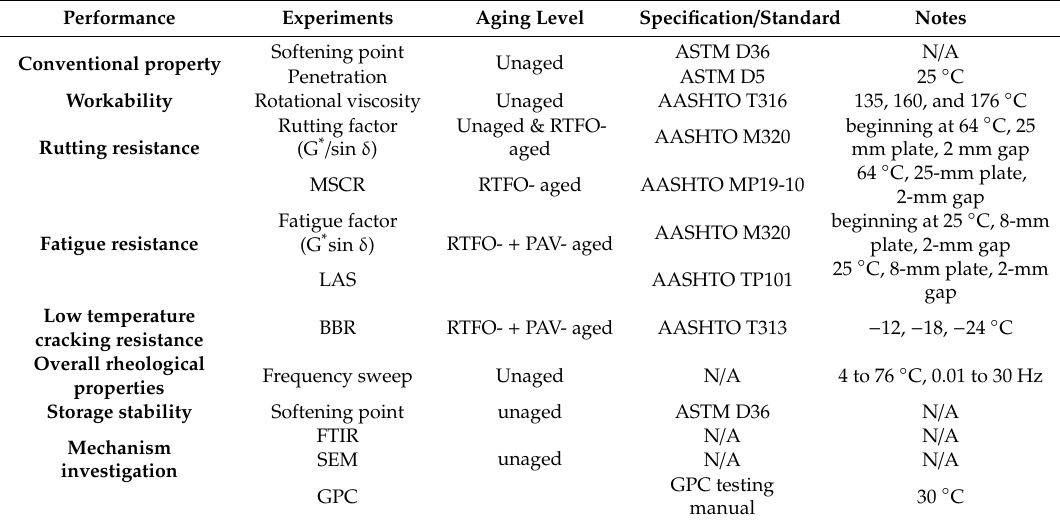
Table 1. Details of laboratory tests.